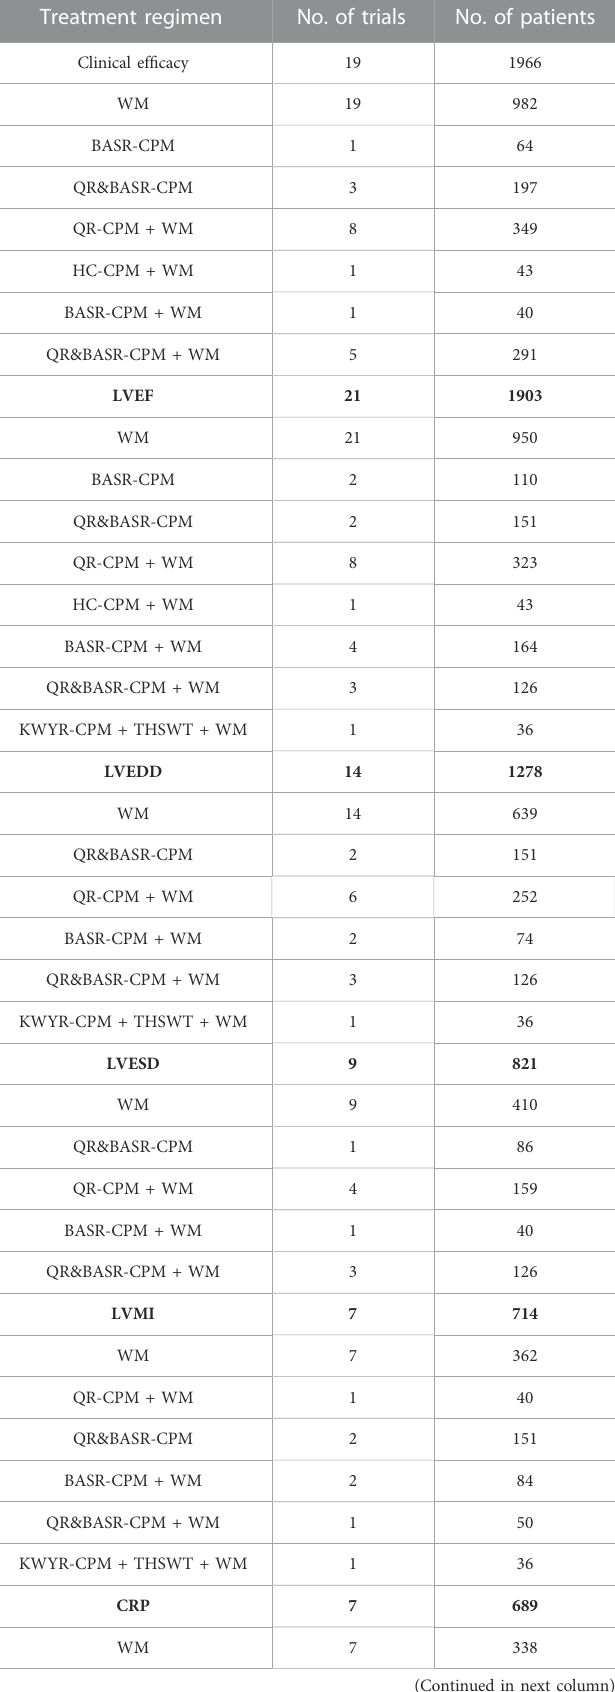
TABLE 3 ( Continued ) Detailed information for each treatment regimen of all